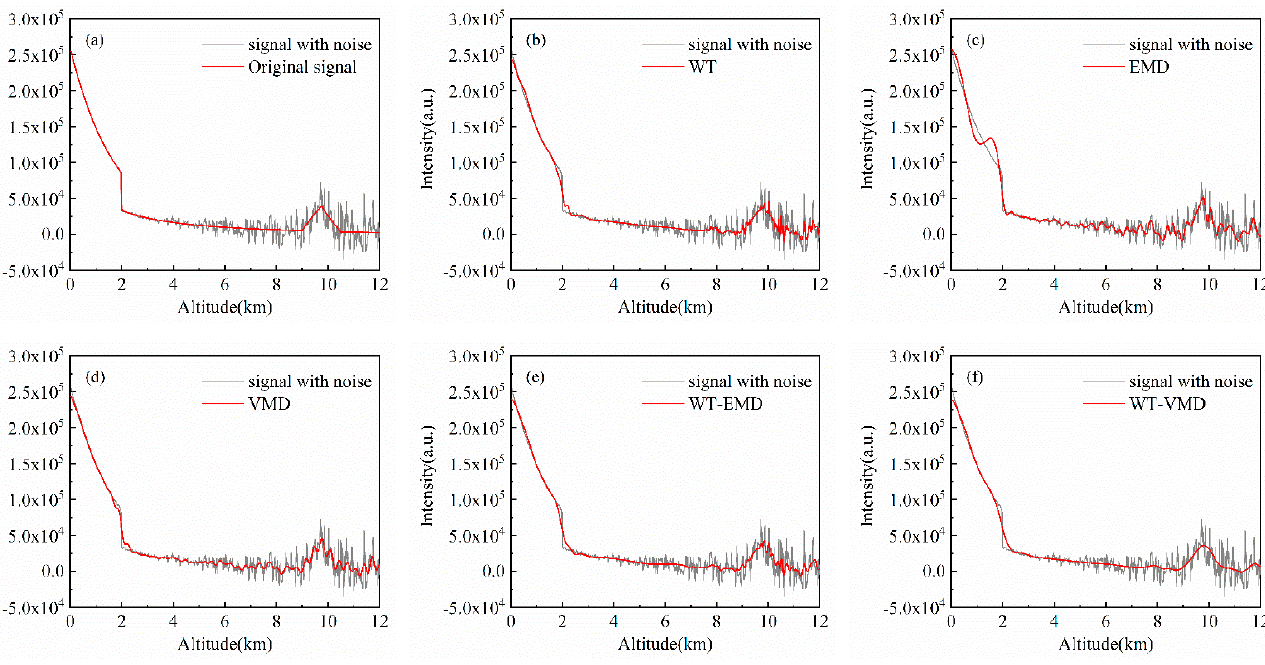
Figure 7. Experimental results of denoising of 100-pulse cumulative simulation signals (with aerosol and clouds): ( a ) original signal; ( b ) WT; ( c ) EMD; ( d ) VMD; ( e ) WT-EMD; ( f ) WT-VMD. Table 5. Evaluation index of 100-pulse cumulative signal (with aerosol and clouds) after de- noising.